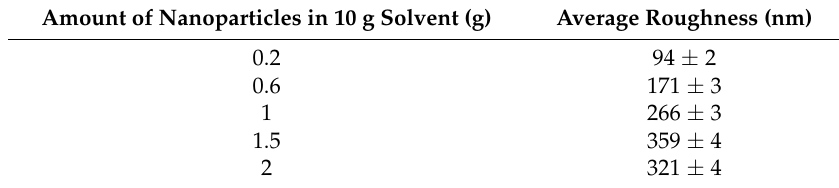
Figure 1. Static Contact angle and roll-off angle as a function of varying nanoparticle composition. Table 1. Average surface roughness values for coating as a function of varying nanoparticle